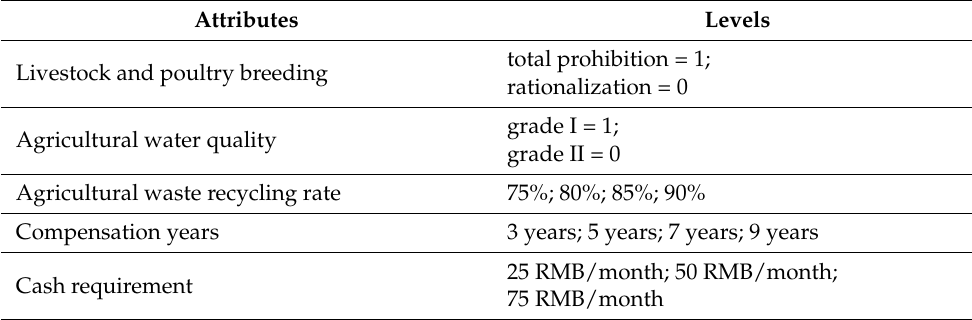
Table 1. Description of attributes and levels. Attributes Levels Livestock and poultry